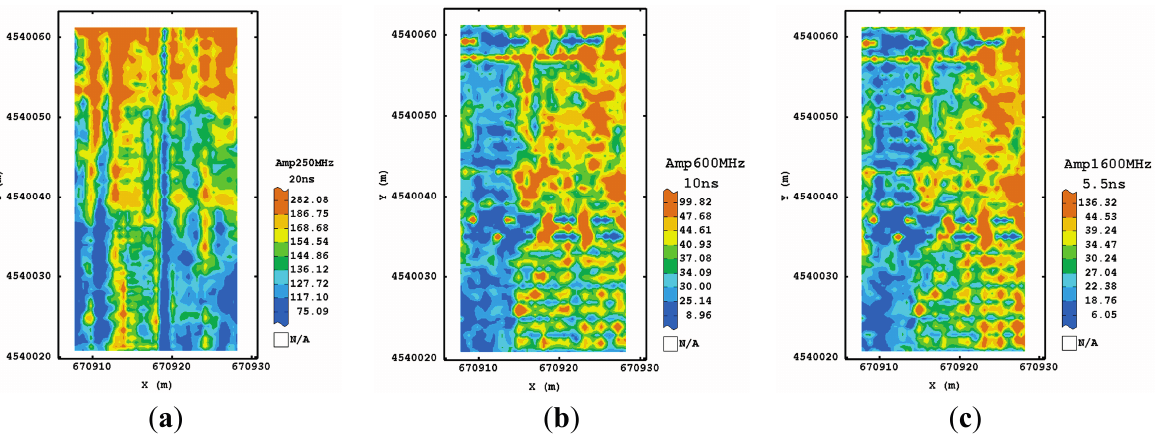
Figure 10. Maps of estimated amplitude for 250 MHz ( a ); 600 MHz ( b ) and 1600 MHz ( c ) frequencies using the sixth processing procedure. (Colour scale uses iso-frequency